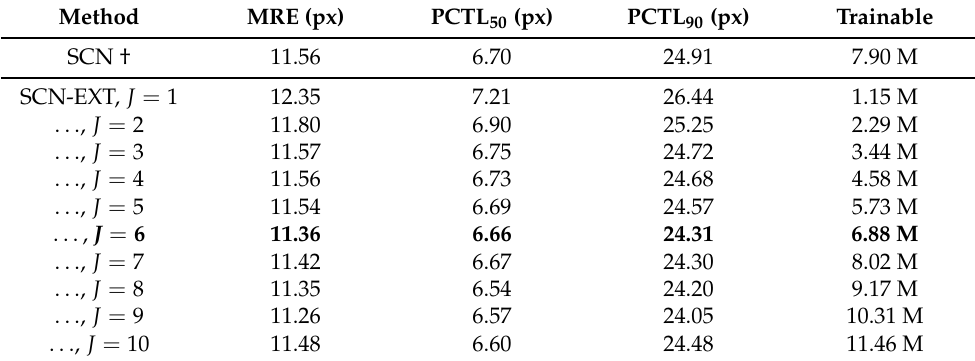
Table 3. Effectiveness of different SCN-EXT architectures on cephalometric landmark detection on fold 1 of the AUDAX private database. The column MRE denotes the mean and standard deviation of the radial error, while columns PCTL 50 and PCTL 90 denote the 50th (i.e., median value) and 90th percentile of the radial error, respectively. All values are in pixels (“px”). The column “trainable” presents the number of trainable parameters in millions.